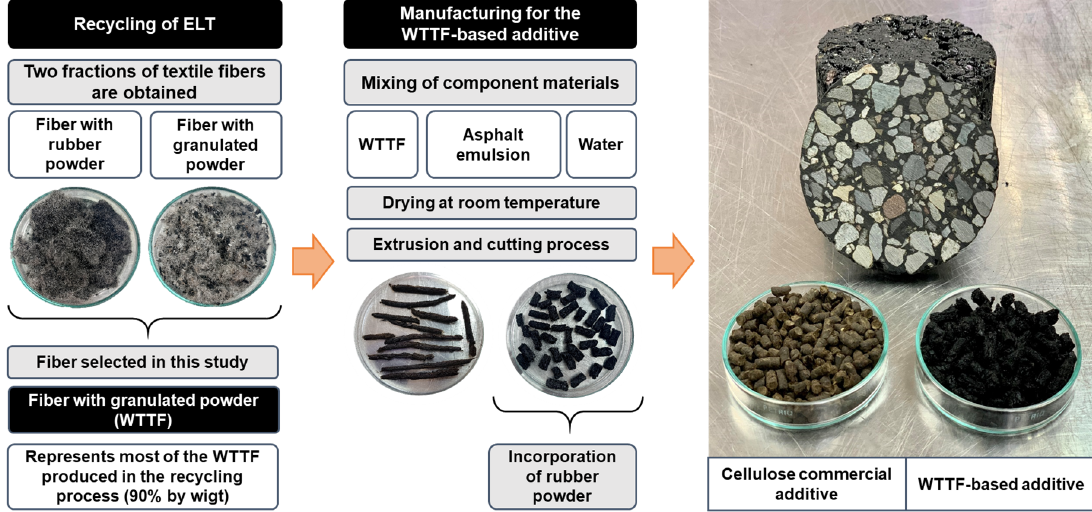
Figure 1. Development of the WTTF ‐ based additive.